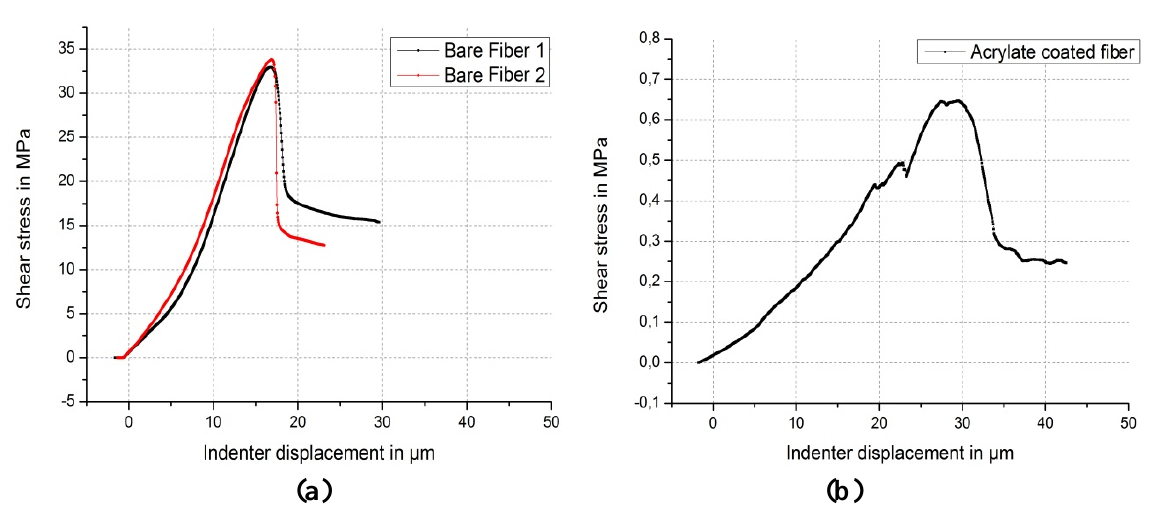
Figure 6. Results of the indentation tests. The bare fiber ( a ) is able to bear about 50 times more stress than the glass fiber with the acrylate coating ( b